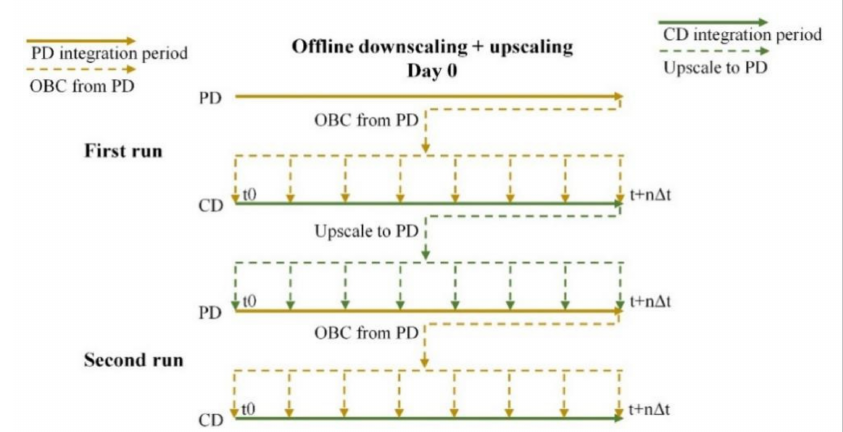
Figure 3. Time scheme and grid communication of the offline two-way methodology proposed in this article. Each day is run twice (or more) in order to receive updated open boundary conditions (schematic channels) and discharges